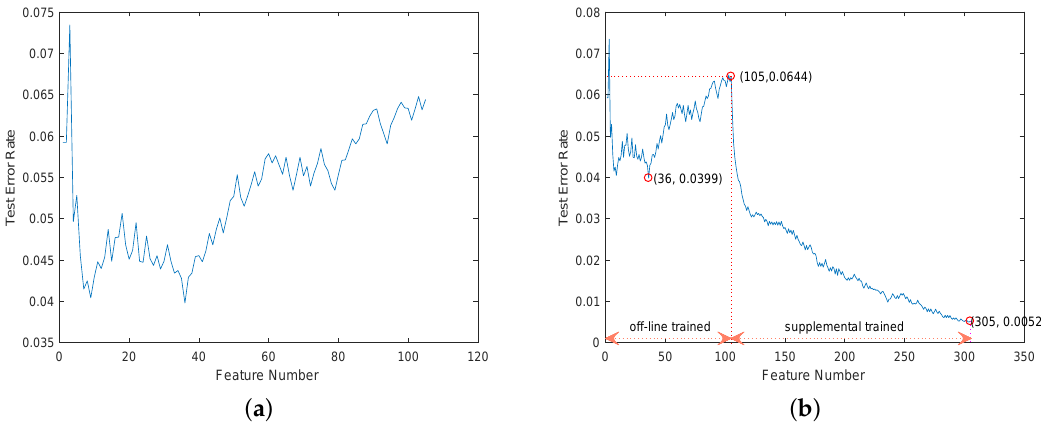
Figure 9. The curves of the feature number and the test error rate on triangular sign detection. The curve in ( a ) is the performance of the off-line-trained AdaBoost-based detector. The curve in ( b ) is the performance of the supplemental trained AdaBoost-based